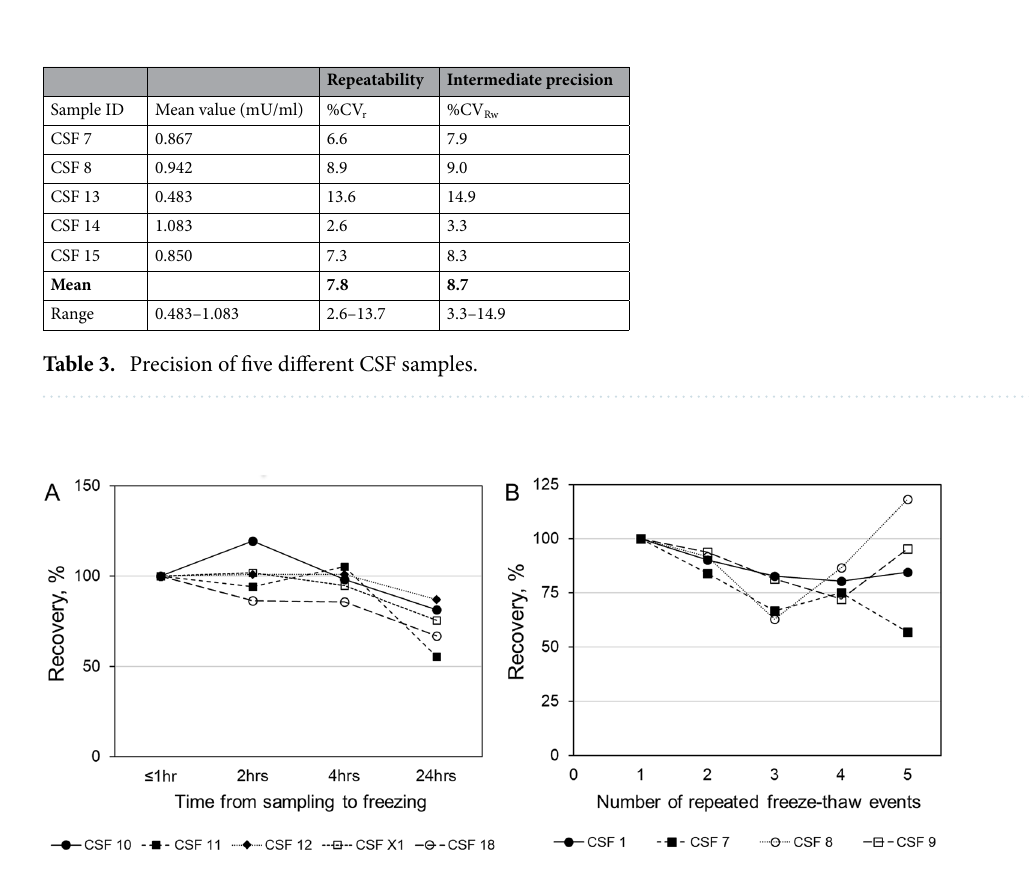
Figure 2. Preanalytical conditions affecting GCase activity in CSF samples. ( A ) Stability of the GCase activity in CSF upon time-delay before freezing. After LP, samples were aliquoted and kept at 4 °C before being frozen within 1 h, 2 h, 4 h or 24 h. ( B ) Stability of the GCase activity assessed in four CSF samples after freeze–thaw